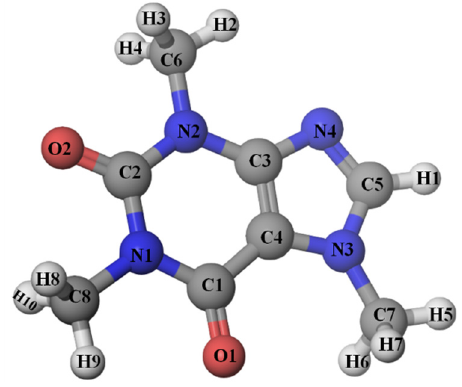
Figure 1. Structure of caffeine molecule and atom-numbering scheme.